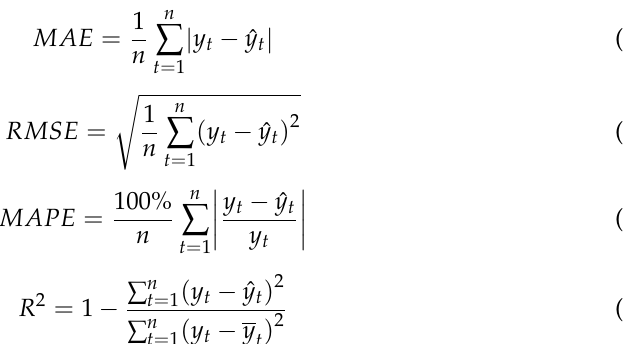
Table 1. Polynomial regression model of confirmed case prediction over five days.